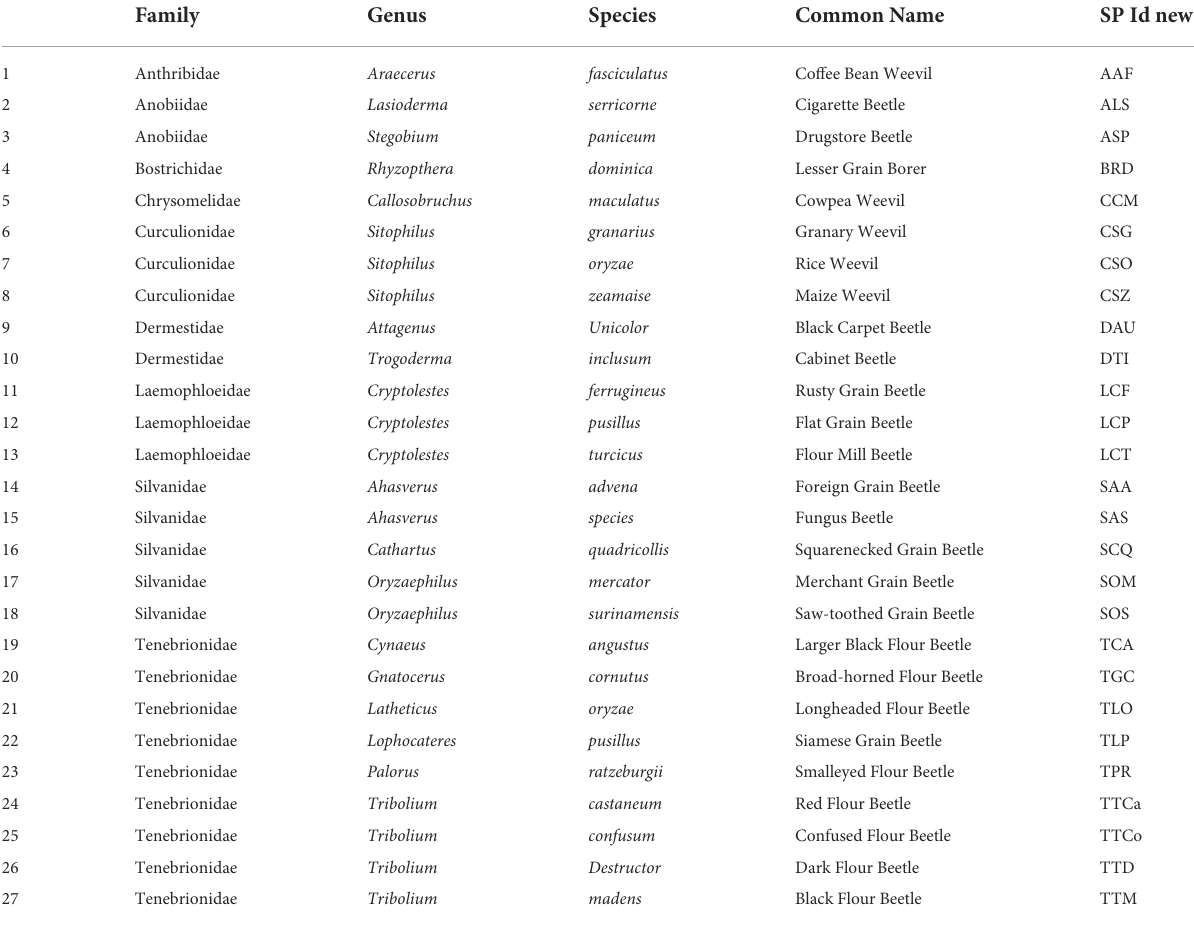
TABLE 1 The complete list of pantry beetles used in this study, listed alphabetically by their family, genus, species and common names, with